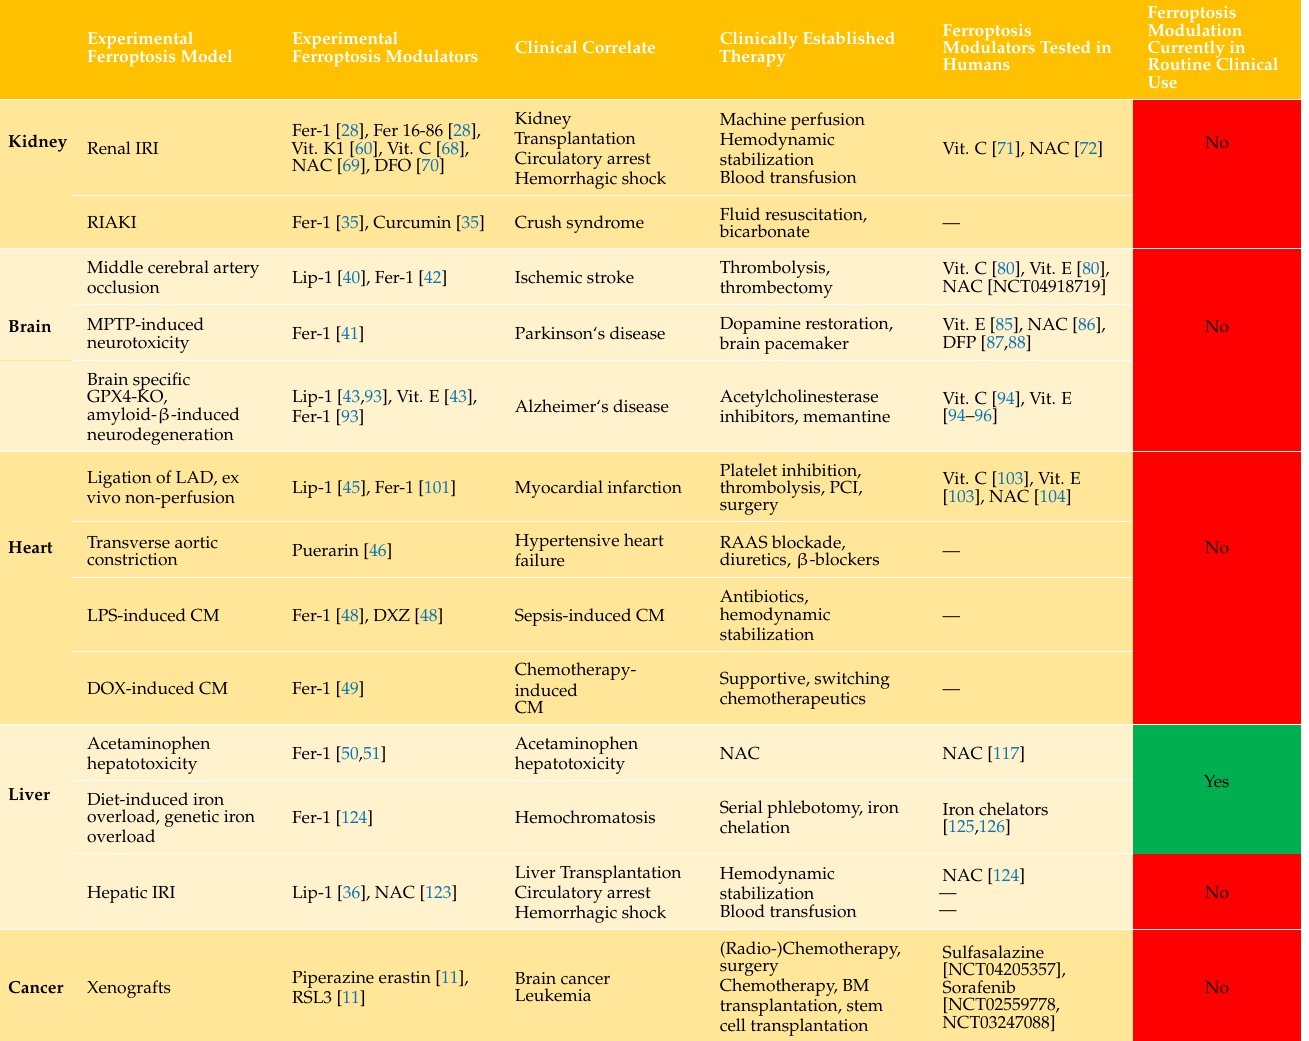
Table 1. Clinically relevant ferroptosis models and the state of translation into therapeutic appli- cation. Experimental ferroptotic disease models and the respective inhibitors from preclinical trials (Experimental ferroptosis modulators) are presented along with the respective clinical correlates and their established treatments. The far-right columns indicate whether any type of ferroptosis modu- lator has been tested in the respective setting and whether a ferroptosis inhibitor is recommended in clinical routine. Bone marrow (BM), cardiomyopathy (CM), deferiprone (DFP), deferoxamine (DFO), doxorubicin (DOX), ferrostatin (Fer), glutathione peroxidase 4 (GPX4), ischemia-reperfusion injury (IRI), left anterior descending coronary artery (LAD), liproxstatin-1 (Lip-1), lipopolysaccharide (LPS), 1-methyl-4-phenyl-1,2,3,6-tetrahydropyridine (MPTP), N-acetylcysteine (NAC), percutaneous coronary intervention (PCI), RAS -selective lethal compound 3 (RSL3), renin-angiotensin-aldosterone system (RAAS), rhabdomyolysis-induced acute kidney injury (RIAKI), and vitamin